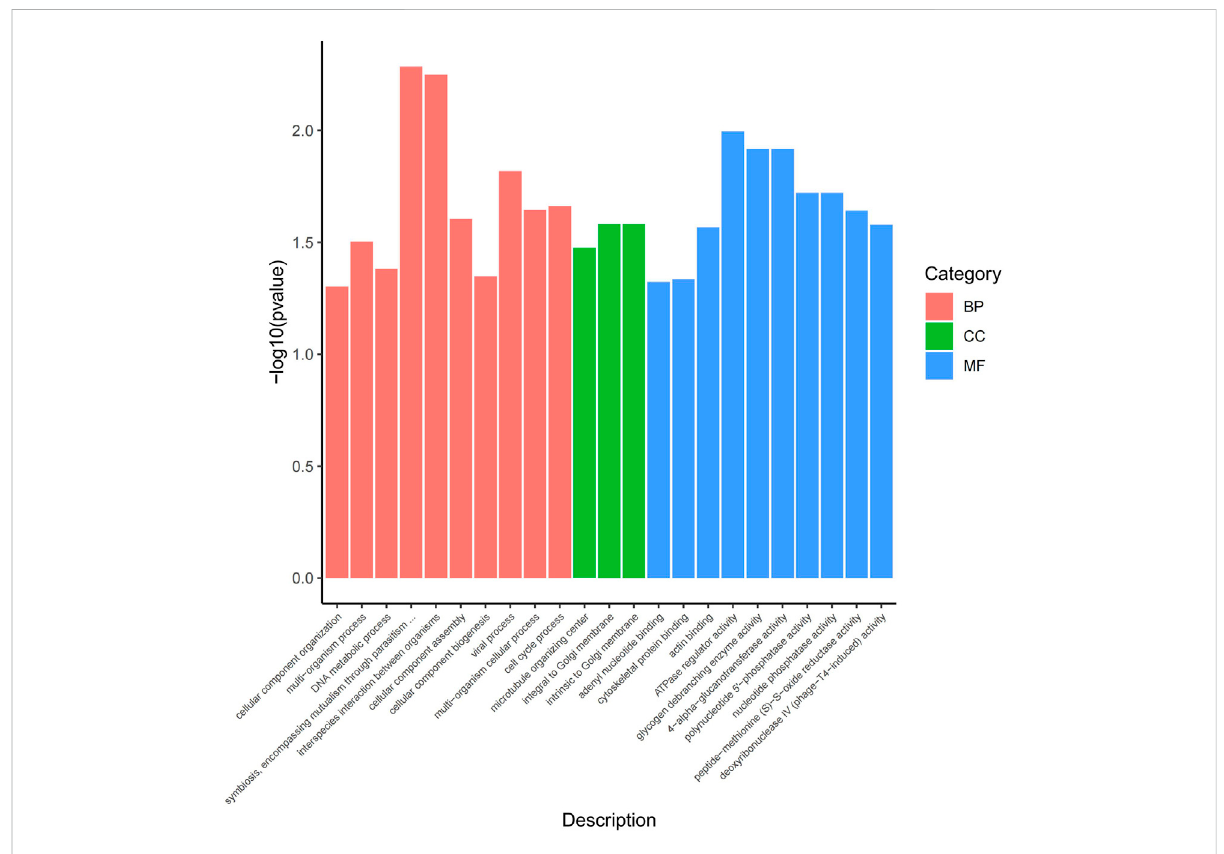
FIGURE 7 GOenrichmentmap.ThehorizontalaxisrepresentstheGOtermofthenextlevelofthethreecategoriesofGO,andtheverticalaxisrepresents the p value